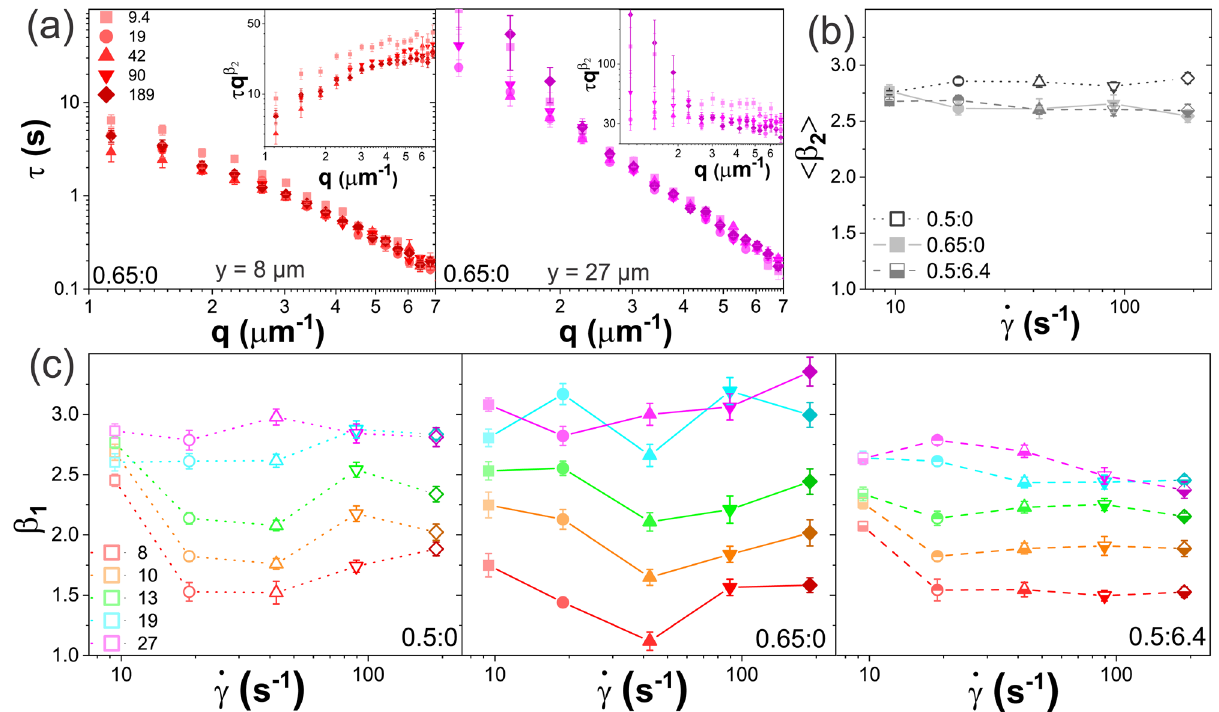
Fig. 4 | DNA blends exhibit fl ow-like stress response that is maximized at ‘ resonant ’ strain rates. a τ ð q Þ versus wavevector q for 0.65:0 evaluated nearest (left, red, y =8 μ m)and farthest (right, purple, y =27 μ m) from strains with rates of _ γ =9.4s − 1 (squares), 19s − 1 (circles), 42s − 1 (upright triangles), 90s − 1 (inverted trian- gles), and 189s − 1 (diamonds). Color gradients from light to dark indicating increasing _ γ . Insets: scaled decay times τ q β 2 versus q show the biphasic behavior with (left) superdiffusive motion near the strain site versus (right) subdiffusion far from the strain. b Mean τ ð q Þ scaling exponent β 2 determined from fi ts to τ ð q > q c Þ